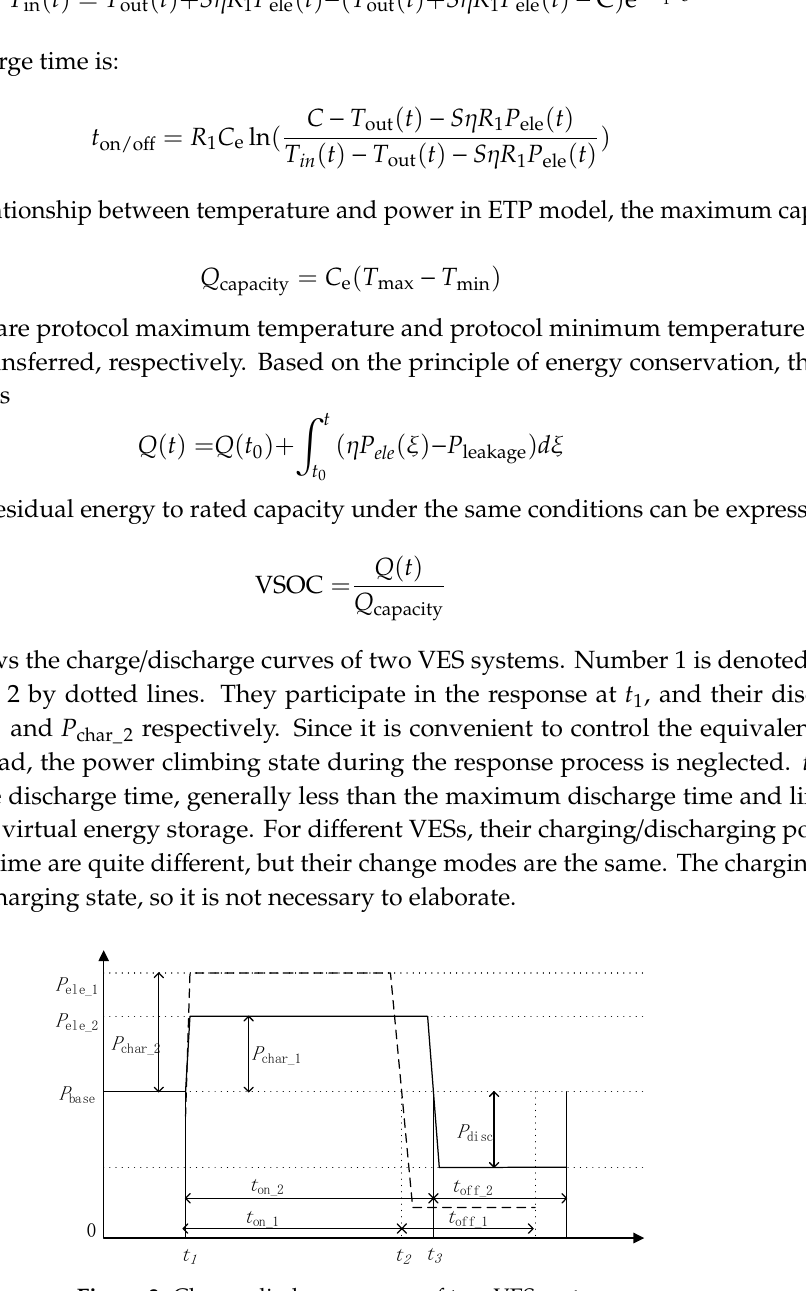
Figure 3. Charge-discharge curves of two VES systems.